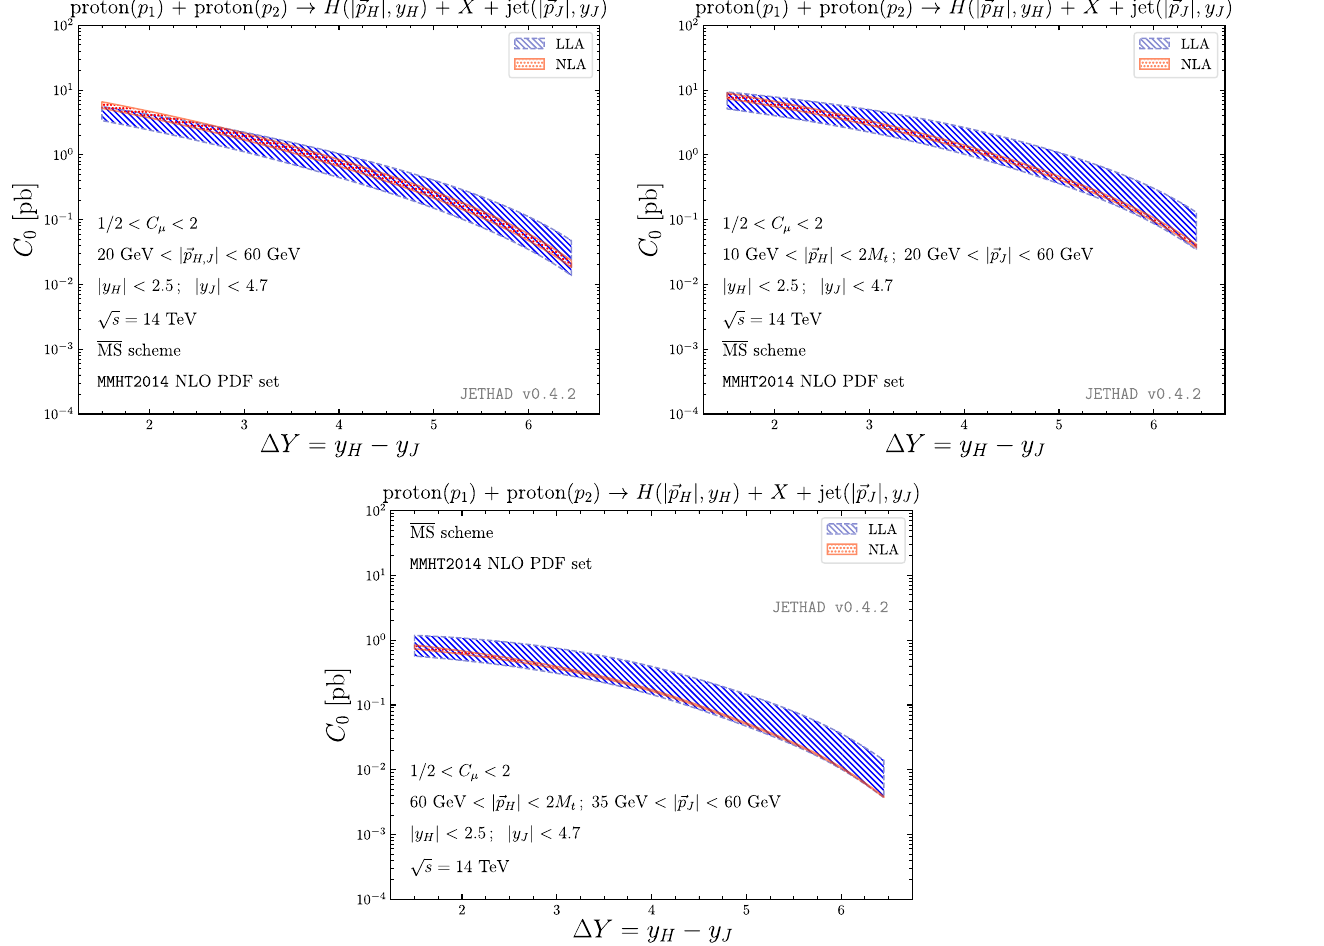
Fig. 4 (cid:6) Y -dependence of the ϕ -averaged cross section, C 0 , for the inclusive Higgs-jet hadroproduction in the three considered p T -ranges and for √ s = 14 TeV. Shaded bands give the combined effect of the scale variation with the uncertainty coming from the phase-space numerical integration